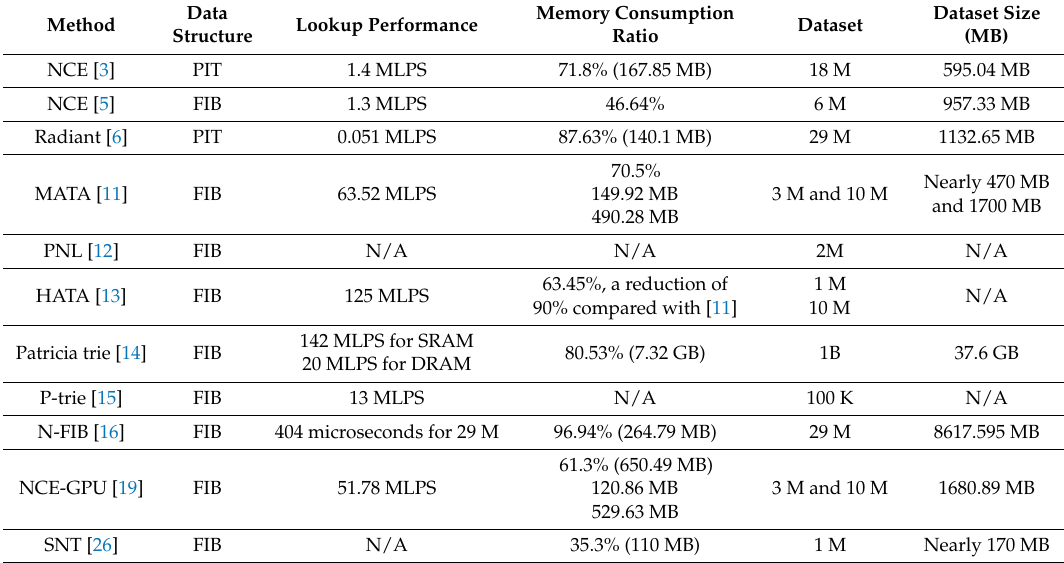
Table 4. Comparison of lookup throughput based on Trie-based schemes.